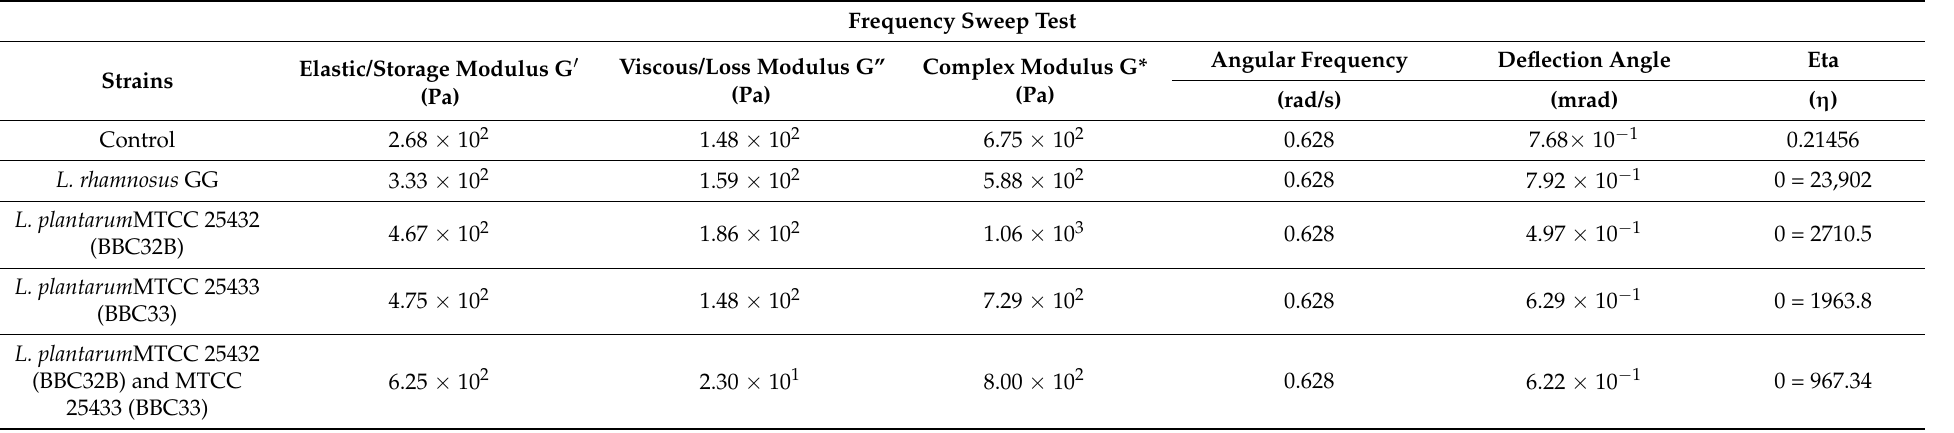
Table 1. Rheological properties; Frequency sweep test indicated the eta ( η ) values among the pure cultures of L. rhamnosus GG (23902 Pa) followed by L. plantarum MTCC 25432 (BBC32B) (2710.5), L. plantarum MTCC 25433 (BBC33) (1963.8 Pa) and combination of both L. plantarum MTCC 25432 (BBC32B) and MTCC 25433 (BBC33) (967.34 Pa) which indicated the probiotic acceptability of the strains based on the rheology. The values are expressed as mean ± SEM of three independent experiments with significant difference ( p <